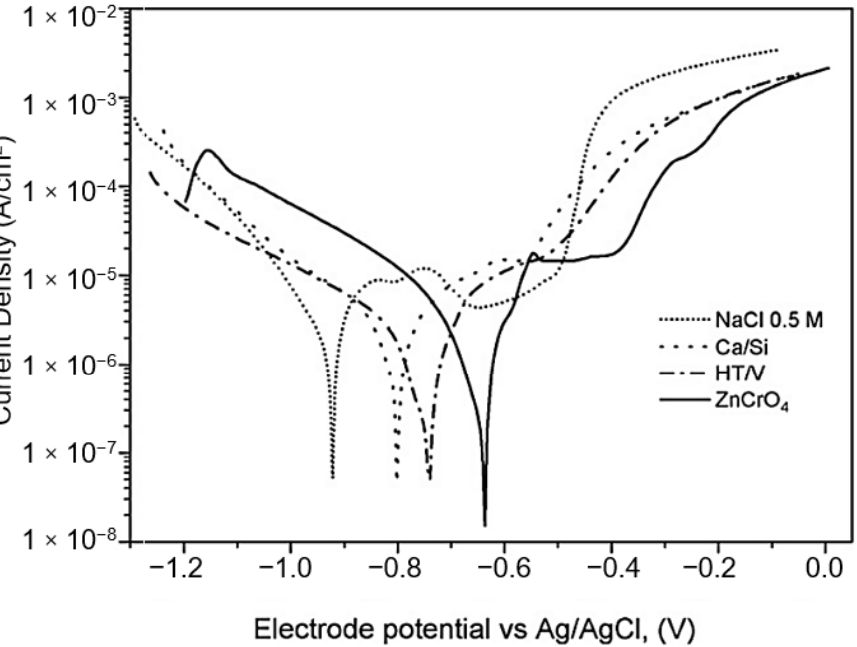
Figure 14. Polarization curves for steel in contact with different anticorrosive pigments in 0.5 M NaCl. Reproduced with permission from Chico et al., Progress in Organic Coatings; published by Elsevier, 2008